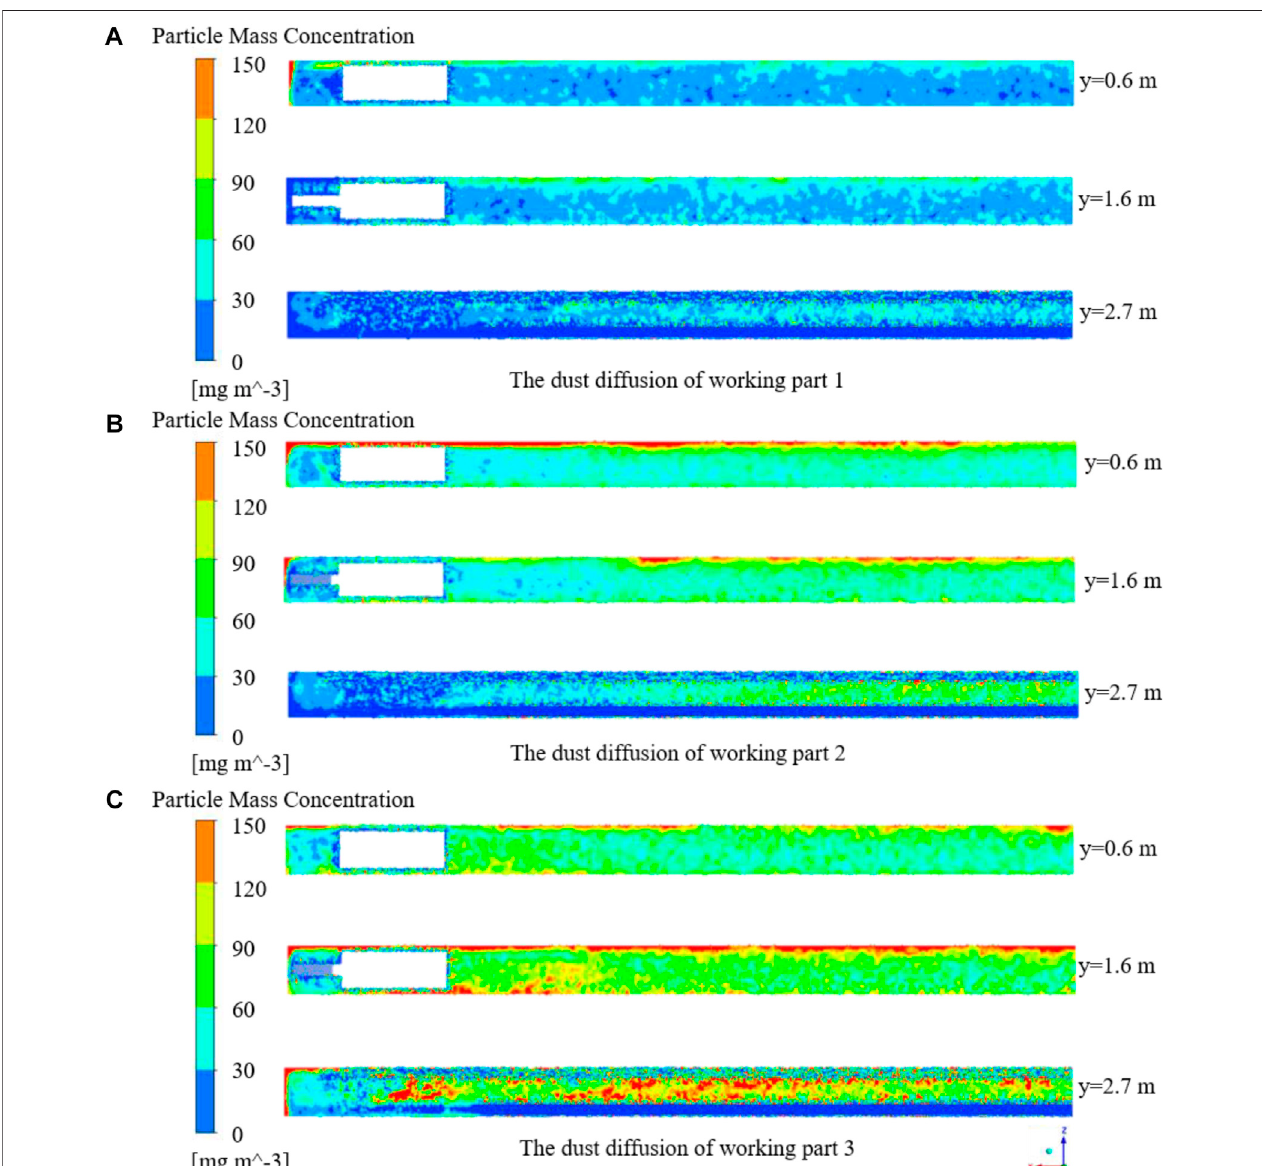
FIGURE 6 | Dust diffusion of the working face: (A) Working face part 1; (B) Working face part 2; (C) Working face part 3.